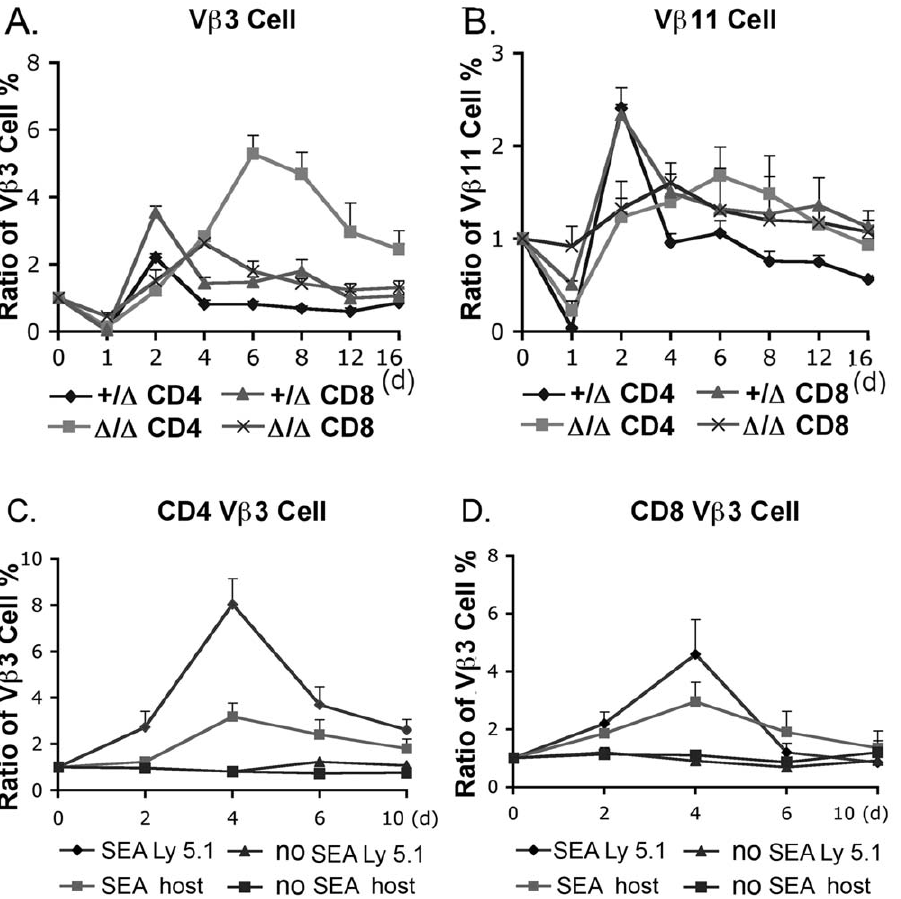
Figure 7. Foxn1 D / D peripheral T cells have abnormal responses to SEA invivo . A and B, showing kinetic response of V b 3 and V b 11 T cells to SEA in vivo . Foxn1 + / D and Foxn1 D / D mice were retro-orbitally injected with SEA 1 m g per mouse, and the percentages of V b 3 and V b 11 were measured in peripheral blood T cells on the indicated day. Y values show the ratio of percentages of V b 3 + and V b 11 + cell in individual day relative to day 0 (before injection of SEA). C and D, the response of transferred Ly5.1 + cells to SEA in Foxn1 D / D mice. Sorted Ly5.1 T cells at 4 6 10 6 per mouse were transferred into Foxn1 D / D mice. One day later, the percentage of V b 3 was measured as day 0 and then SEA 1 m g per mouse was injected. The percentage of V b 3 was continuously measured on the indicated days after injection of SEA and shown as the ratio of the percentage relative to day 0. The results shown were the average from two or three individual experiments.